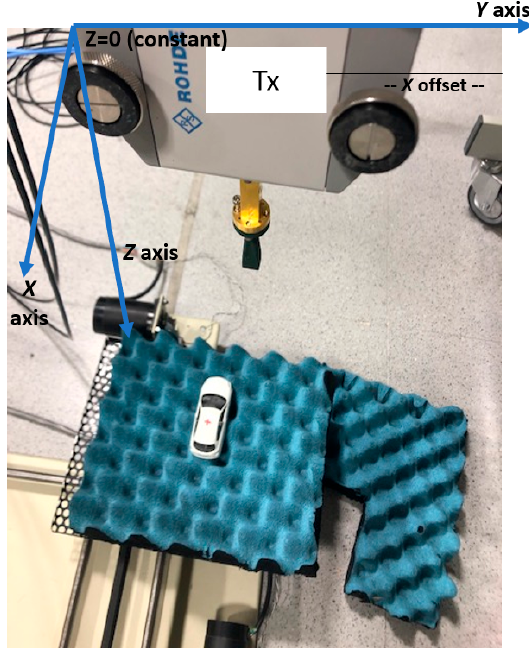
Figure 2. Measurement setup.